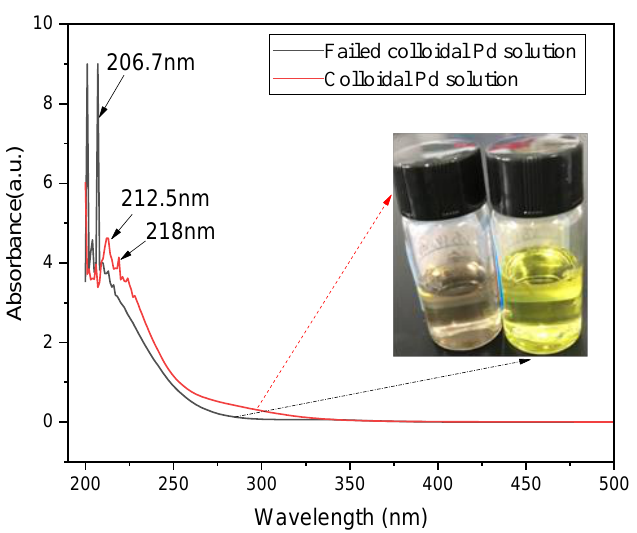
Figure 8. UV–vis spectra and macrograph of activation solution in the glass Figure 8. UV – vis spectra and macrograph of activation solution in the glass bottles.